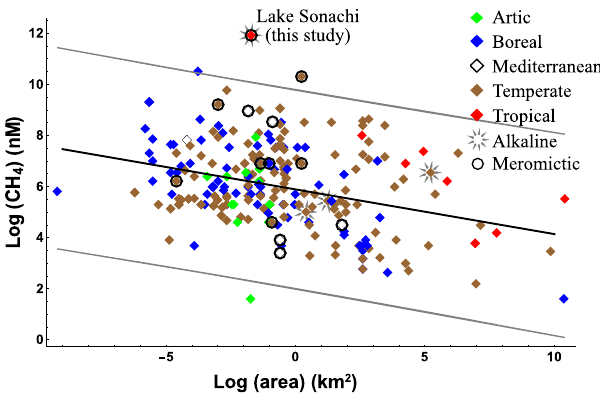
Fig. 1 Literature overview of CH 4 concentration in oxic lake waters. Reported values derive from lakes distributed worldwide across a range of size (i.e., area) and climatic region (i.e., arctic, boreal, Mediterranean, temperate, tropical). Alkaline and meromictic lakes are highlighted. Regression line ( p < 0.001) and con fi dence interval (0.99) are reported. Extended data are reported in Supplementary Table